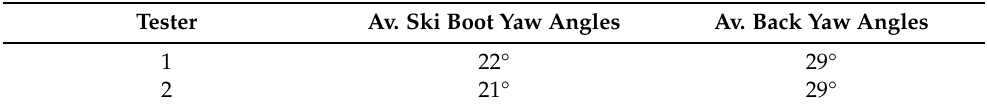
Figure 10. Yaw angle for the ski boots and for the back. Table 6. Average yaw angles for ski boots and